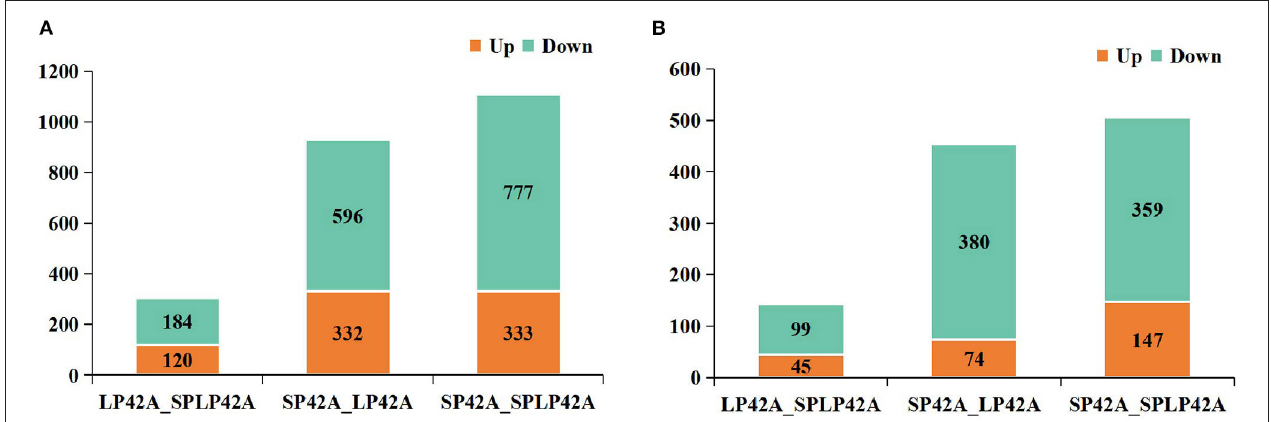
FIGURE 2 | The histogram of DELs and DEMs in different comparable groups. (A) DELs (B) DEMs. Where red and green represent up- or down regulation, respectively.